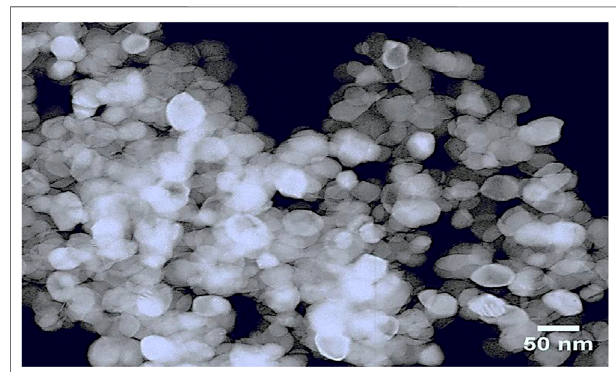
FIGURE 3 | Scanning electron microscope image of Fe – Ag co-doped TiO 2 NPs.